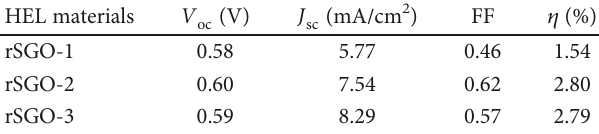
Table 2: The parameters of the experimental device